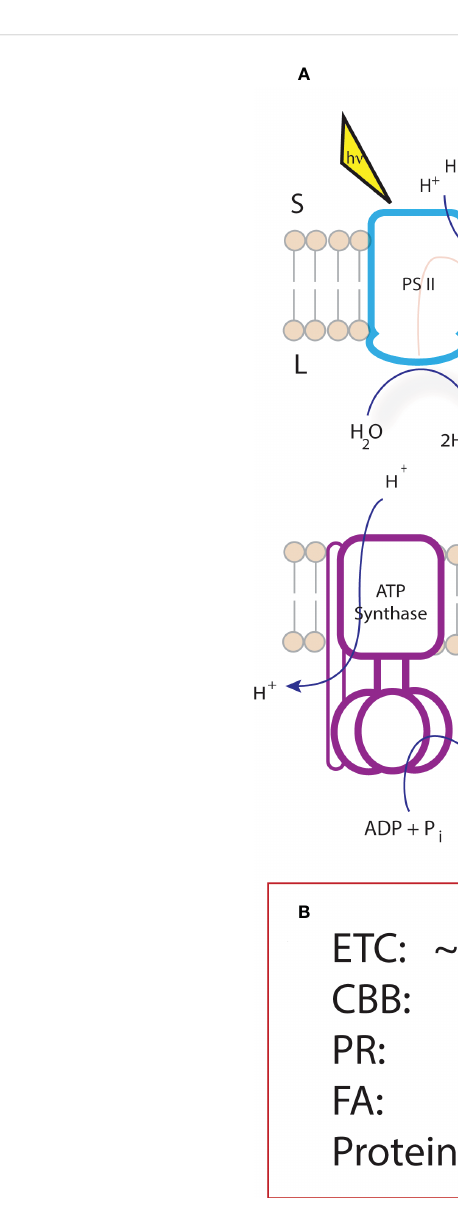
FIGURE 1 Supply and demand of NADPH and ATP within the chloroplast. The proton to electron stoichiometry of proton coupled electron transfer of the light reactions of photosynthesis (as pictured in panel A ) is fi xed at 3H + /e - and, together with the c-ring structure of the ATP synthase, constrains the electron transport chain production to ~1.3 ATP/NADPH. The light reactions supply multiple metabolic sinks within the chloroplast that do not match the ATP/ NADPH resulting in an ATP de fi cit or surplus. (B) indicates pathways of interest for metabolic engineering, and their difference in demand (within the chloroplast) from the ATP/NADPH production of the electron transport chain. CBB, Calvin-Benson-Bassham cycle; PR, photorespiration; FA, Fatty acid biosynthesis; Protein, Protein